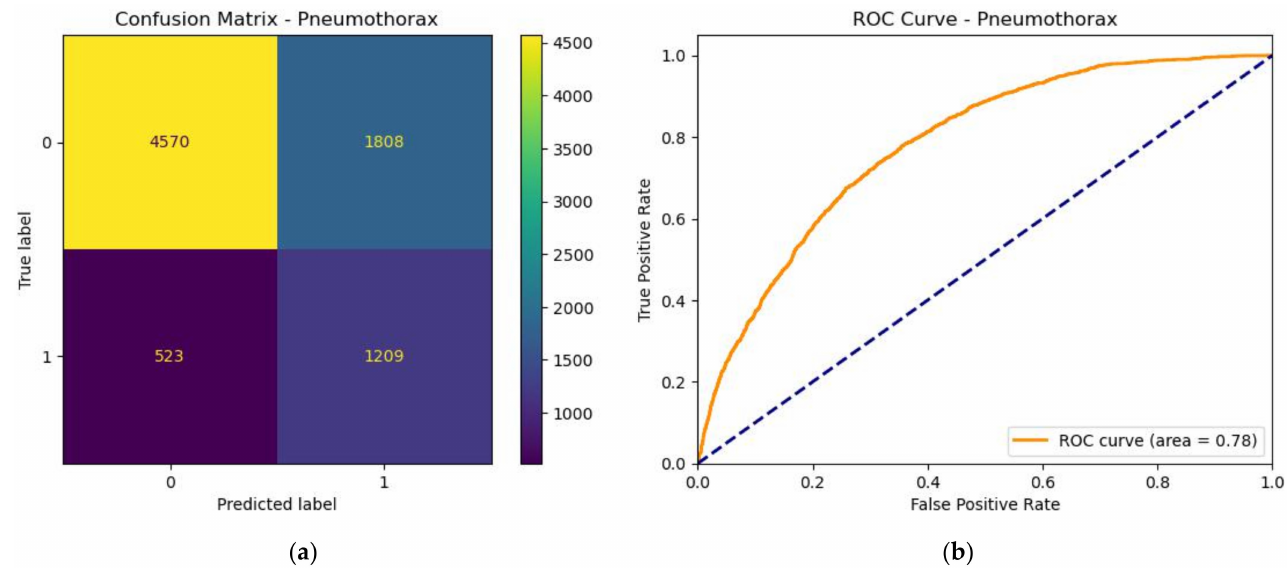
Figure 4. Model quality—Pneumothorax. ( a ) Confusion matrix. ( b ) ROC curve.